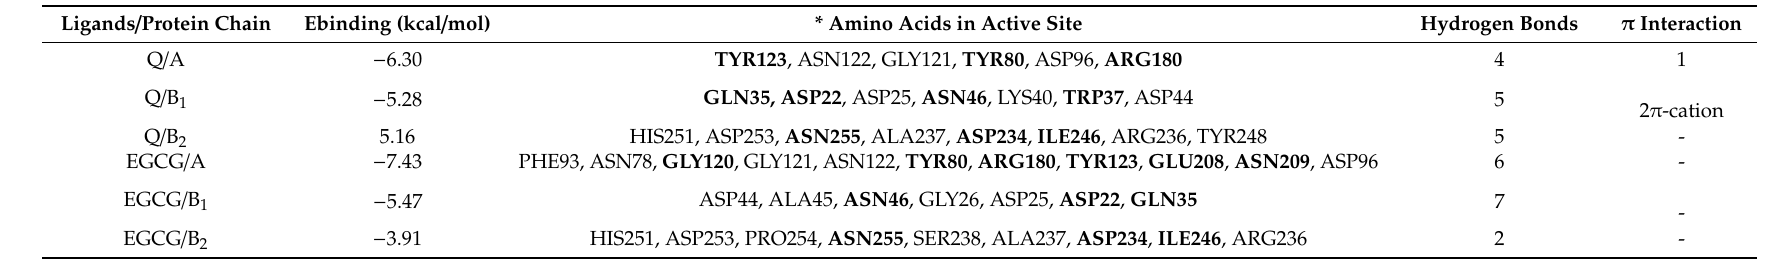
Table 3. Molecular interaction analysis for the ricin protein (A and B chains) and quercetin (Q) and epigallocatechin gallate